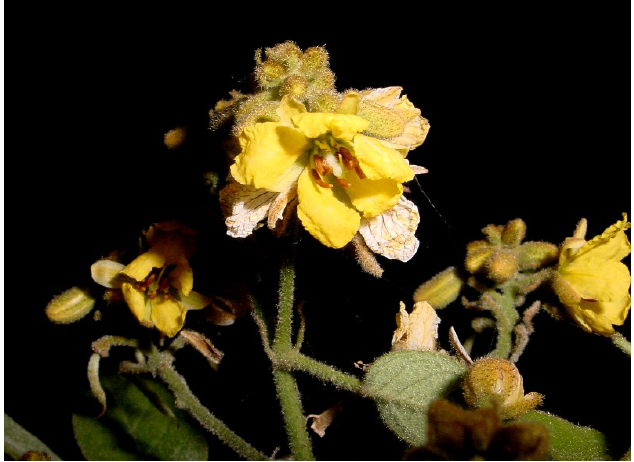
Figure 1. Senna villosa , popularly named saalche by the Mayan